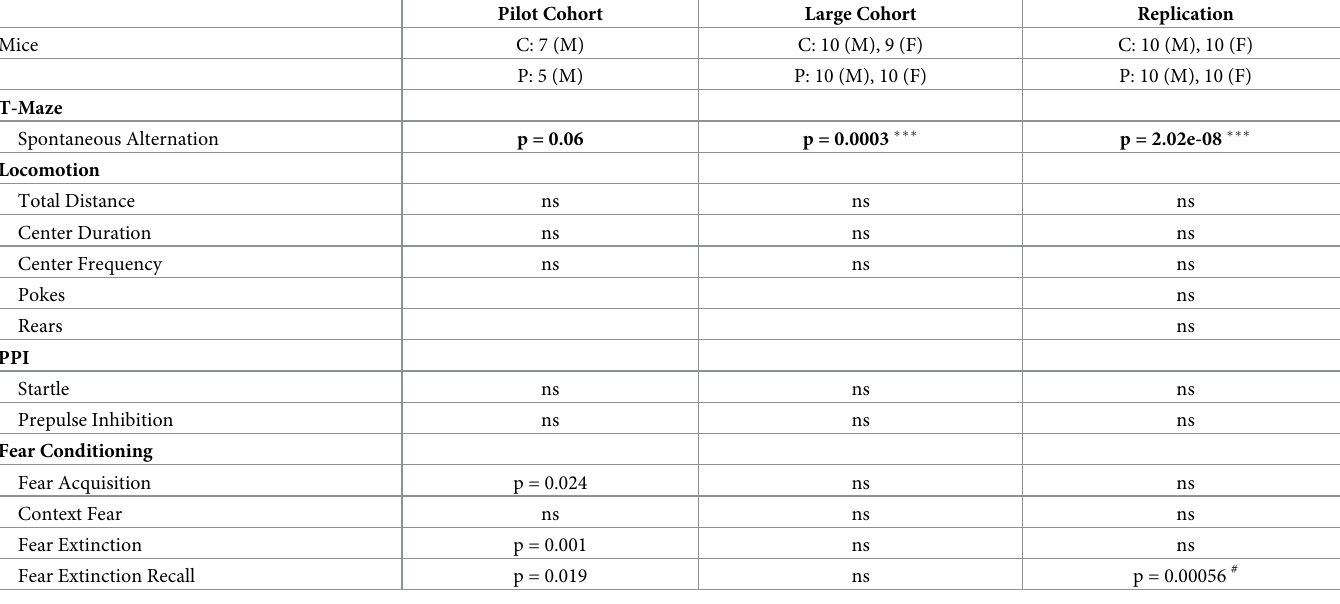
Table 1. Summary of behavioral